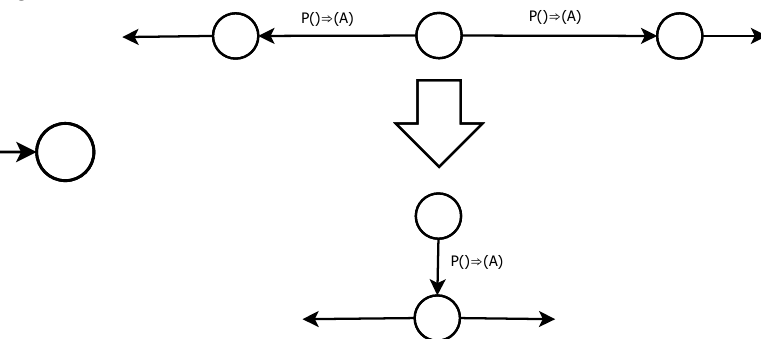
Fig. 11. Duplicate outgoing edge